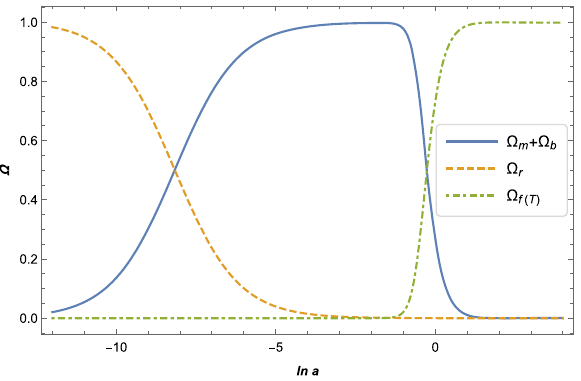
Fig. 4 Evolution of the ratio between the baryonic and dark matter density parameters 0